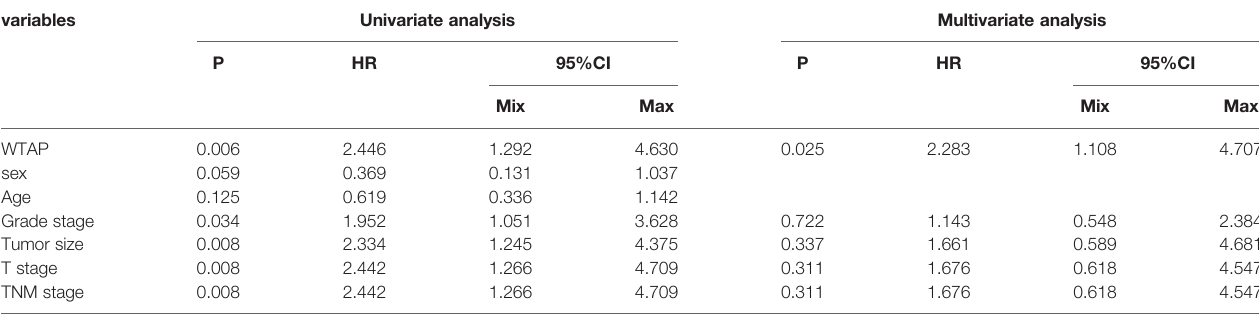
TABLE 3 | Univariate and multivariate analyses of WTAP expression in the cytoplasm associated with overall survival of liver cancer patients. variables Univariate analysis Multivariate analysis